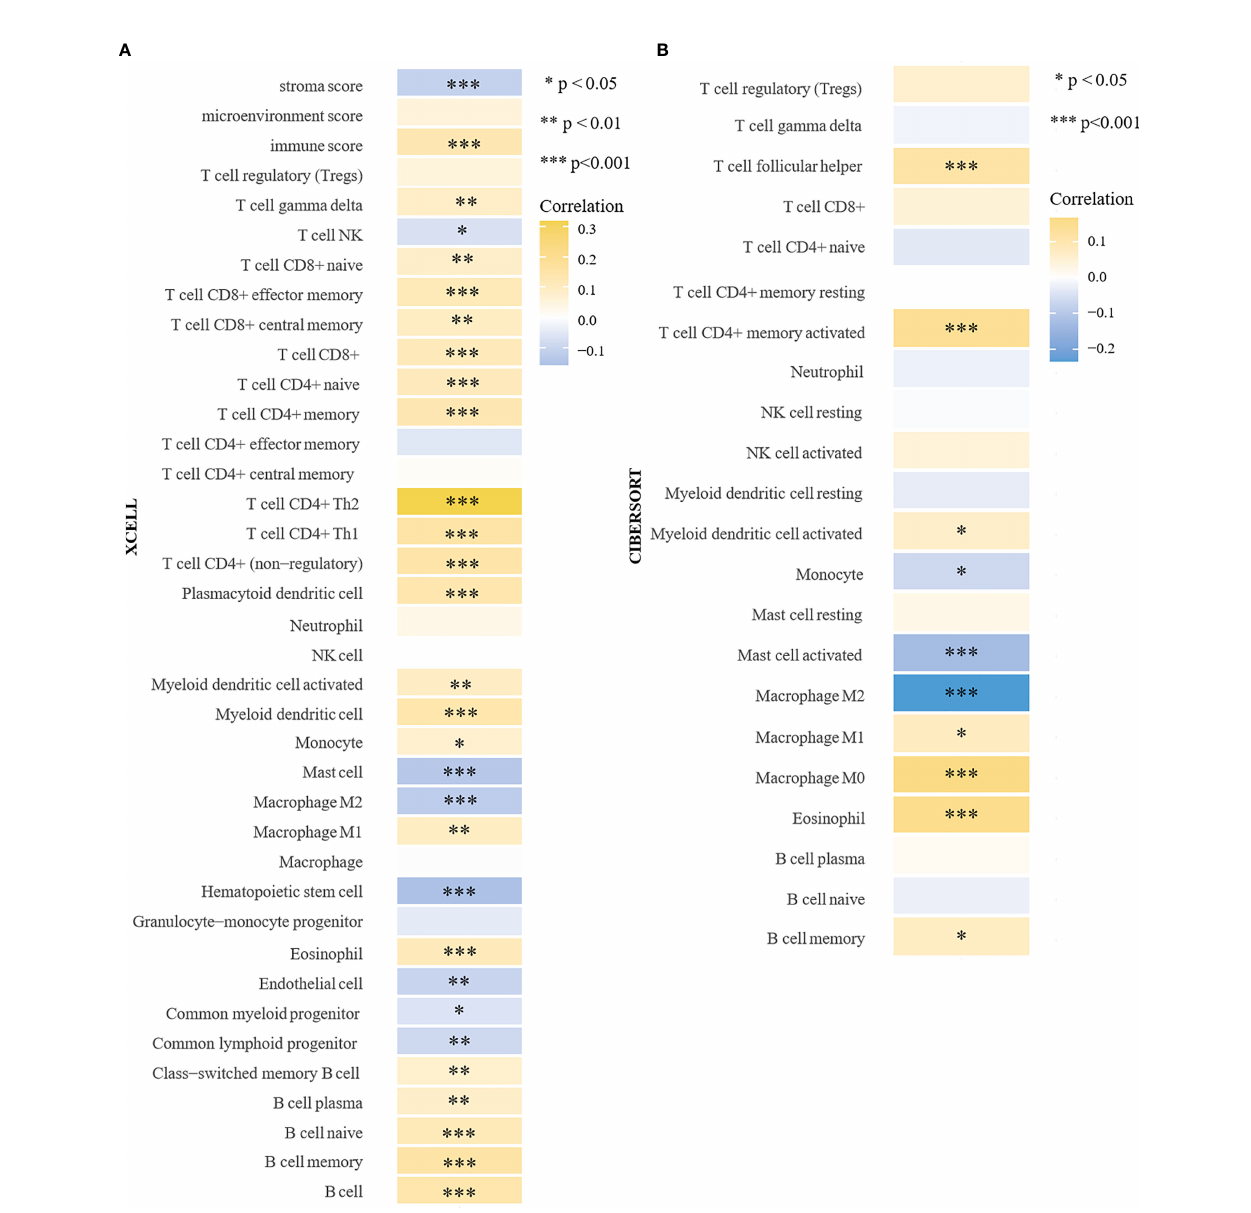
FIGURE 5 | HTR6 expression was correlated with the in fi ltration of immune cells in breast cancer. (A) The analyses using Xcell and (B) CIBERSORT algorithms revealed the correlation between HTR6 expression and stroma score, immune score, and various types of immune cell in fi ltration in breast